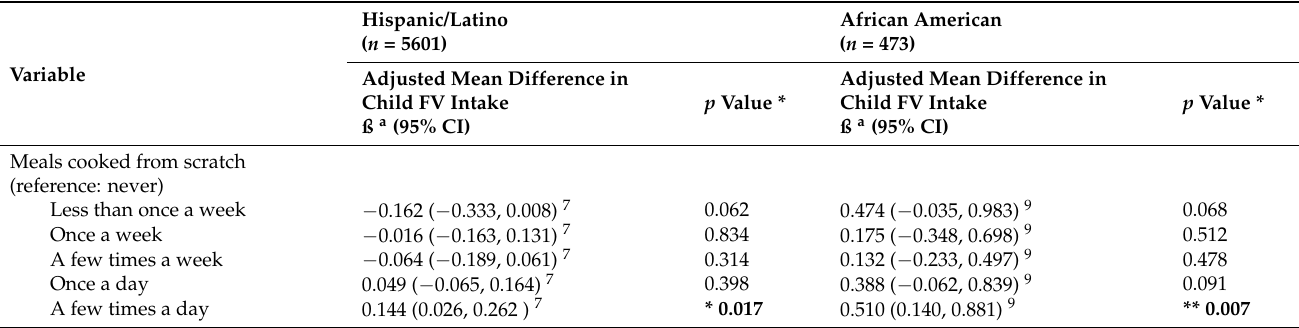
Abbreviations: Cl, Confidence interval. a Regression coefficients were calculated using Multilevel Mixed Effects Linear Regression models. * Boldface indicates statistical significance at * p < 0.05, ** p < 0.01, *** p < 0.001